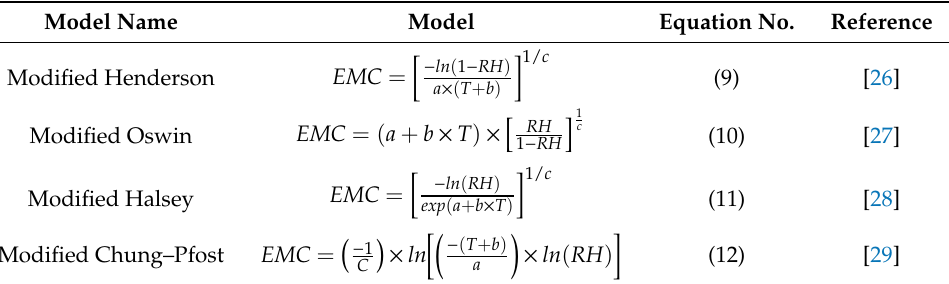
Table 2. Moisture sorption isotherm models.